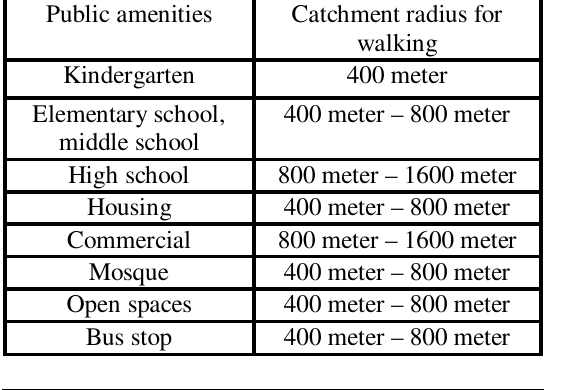
Table 9: Amenities provided in the Range of radius 3 (400 meter) and radius 4 (800meter) Public amenities